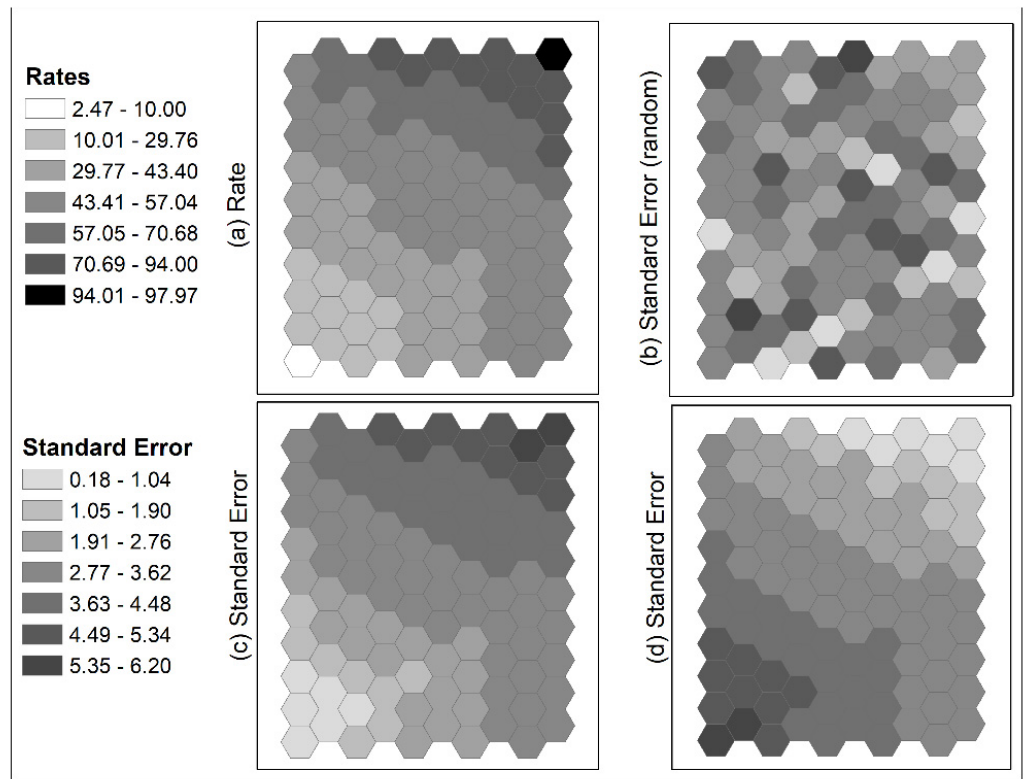
Figure 6. Simulated data for 100-hexagontal tessellation (same as those in Figure 3) with simulated standard error: ( a ) trend surface from lower left to upper right; ( b ) standard errors in a random distribution; ( c ) standard error proportional to estimates; ( d ) standard error inversely proportional to estimates.